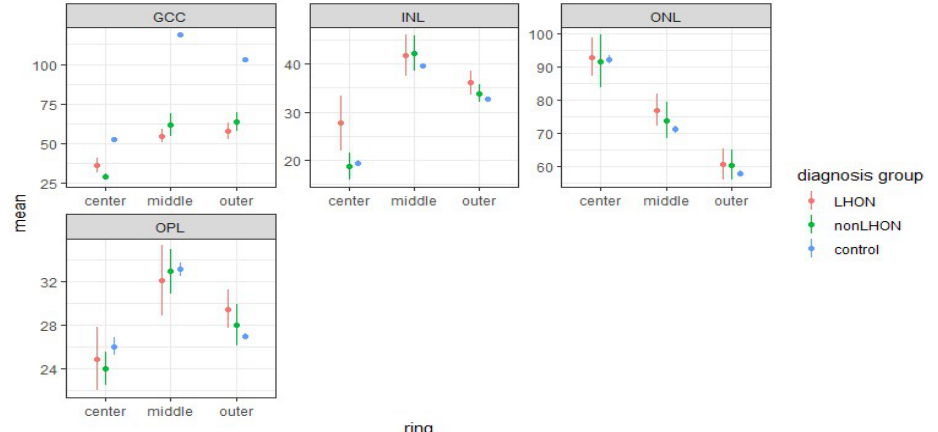
Figure 3. Mean thickness and 95 % confidence intervals of different retinal layers for LHON, nonLHON, and control group, for the center, middle, and outer ETDRS ring. Note thicker inner nuclear layer (INL) in the center of LHON group.